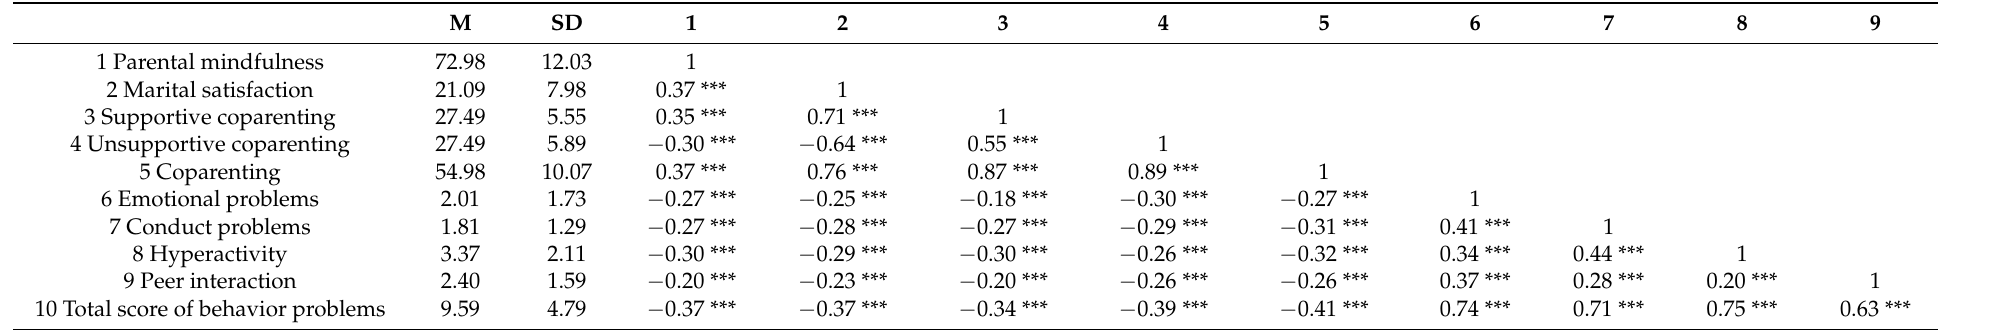
Table 2. Descriptive statistics and correlation